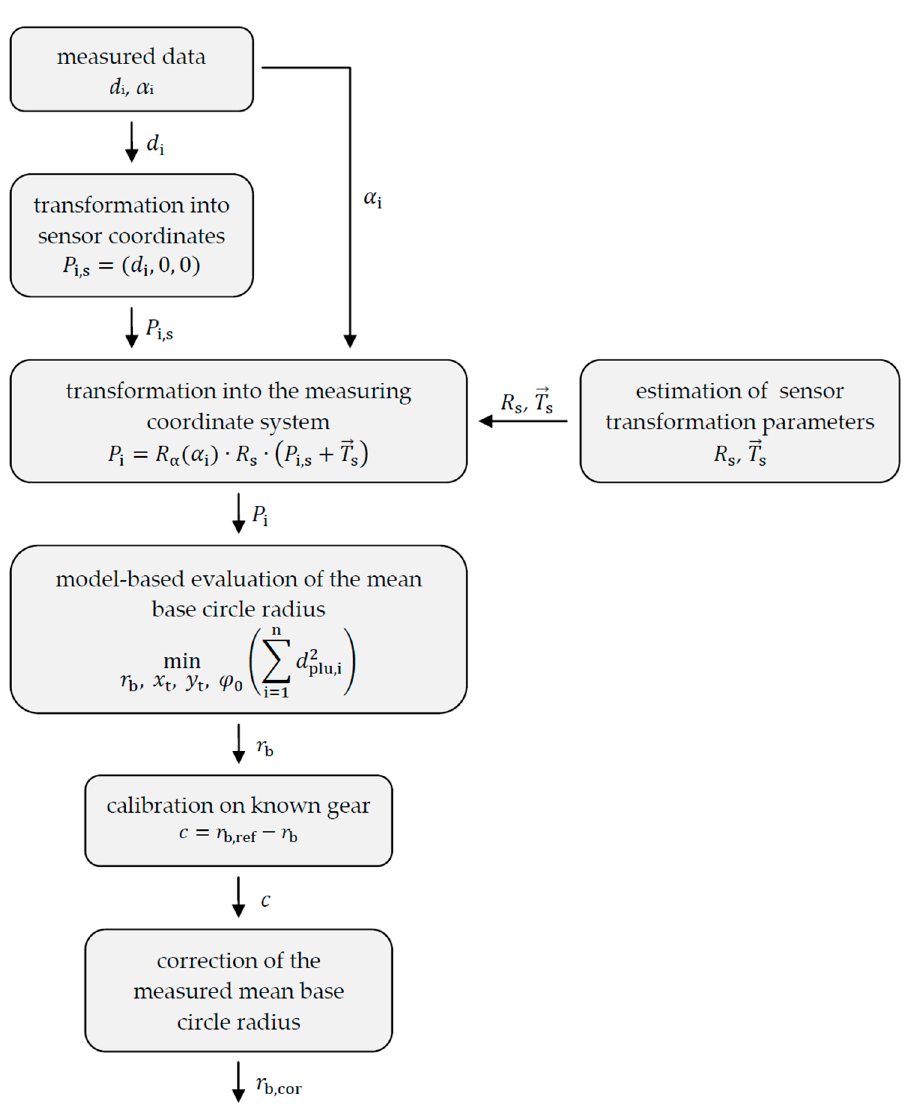
Figure 5. Signal processing to determine the actual mean base circle radius of a gear by calibrating the sensor system with a known gear.